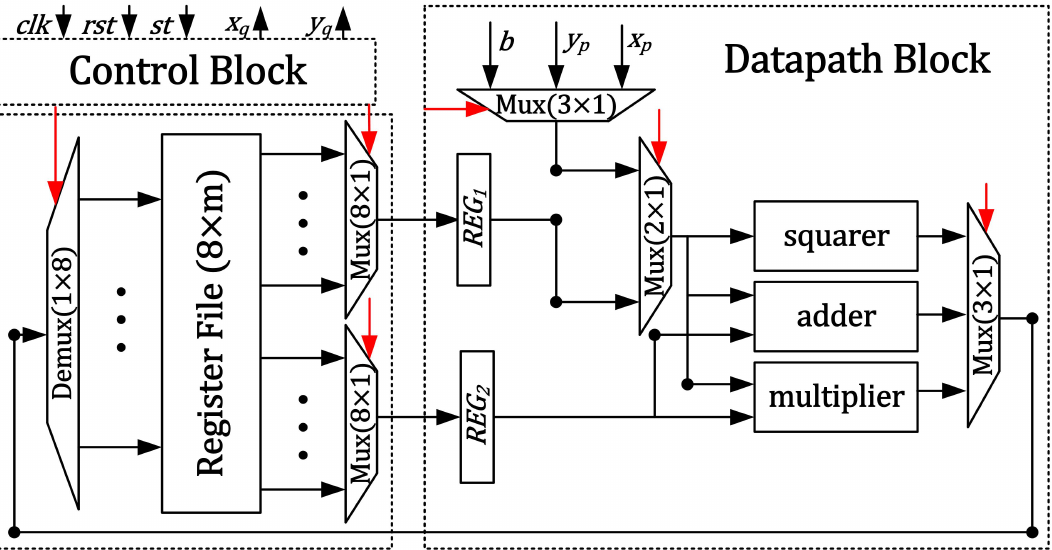
Figure 1. Proposed PM